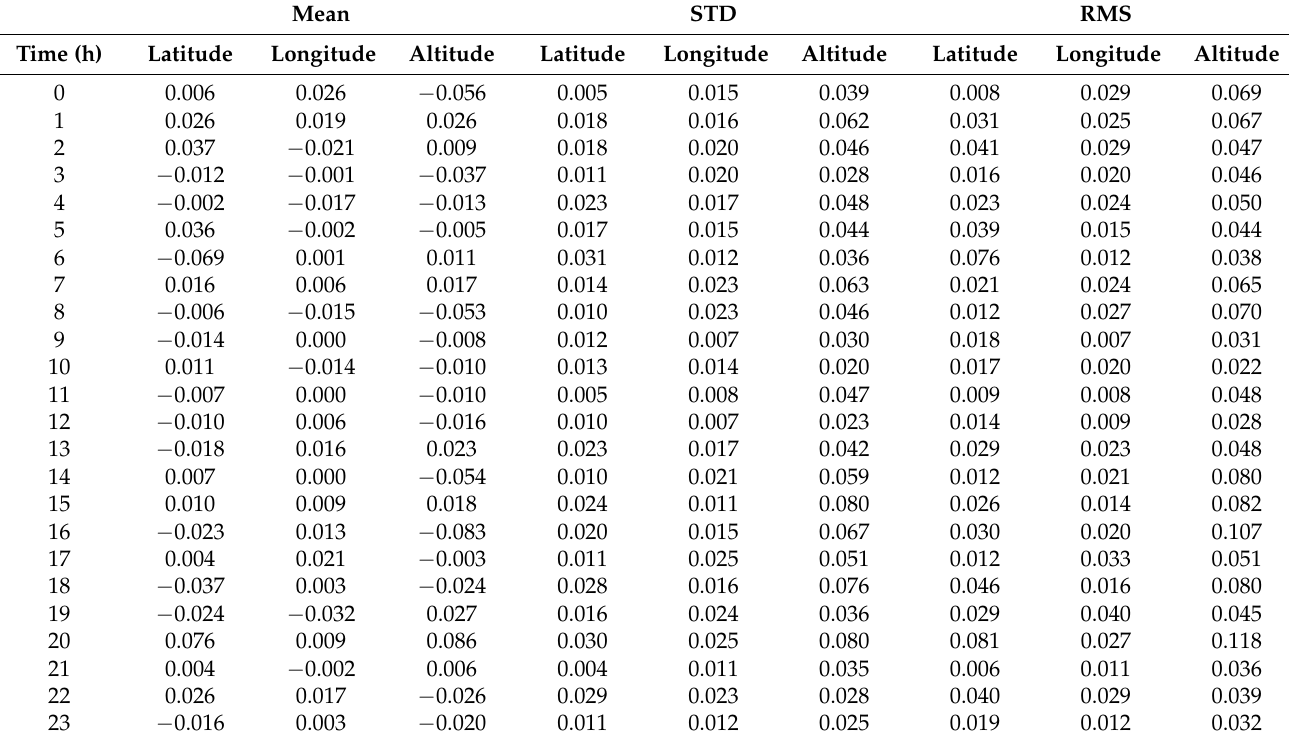
Table 1. Statistical results (expressed in metres) obtained by using only GPS.